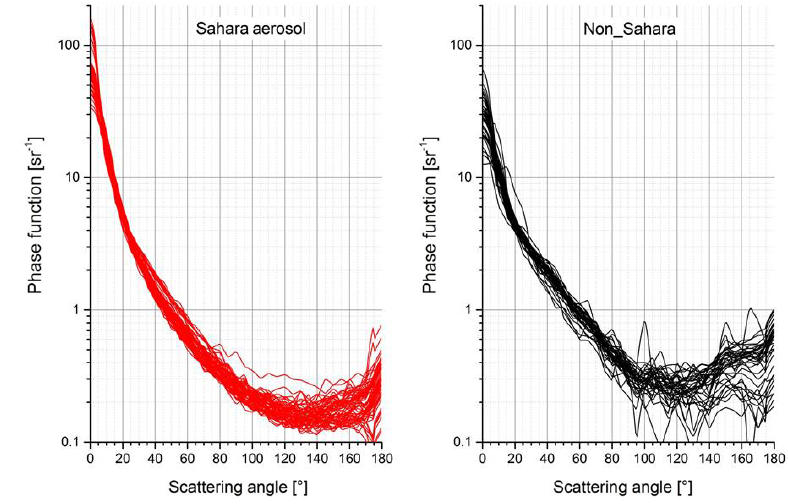
Figure 6. Comparison of the phase function attributed to Sahara and non-Sahara aerosols.